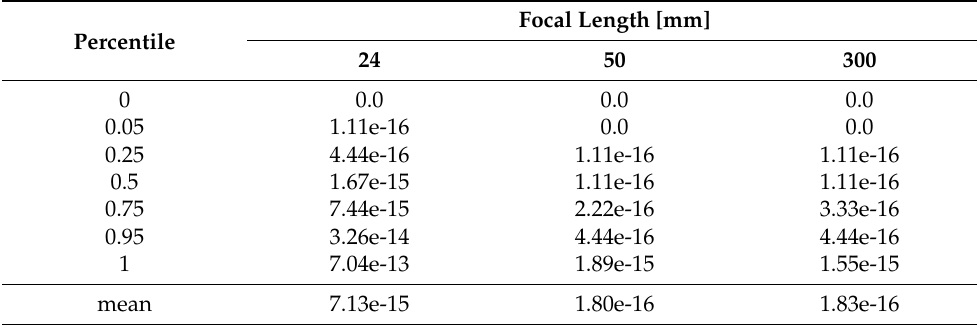
Table 1. Differences in values of vignetting estimators for using the SNILP model with different sequences of approximation